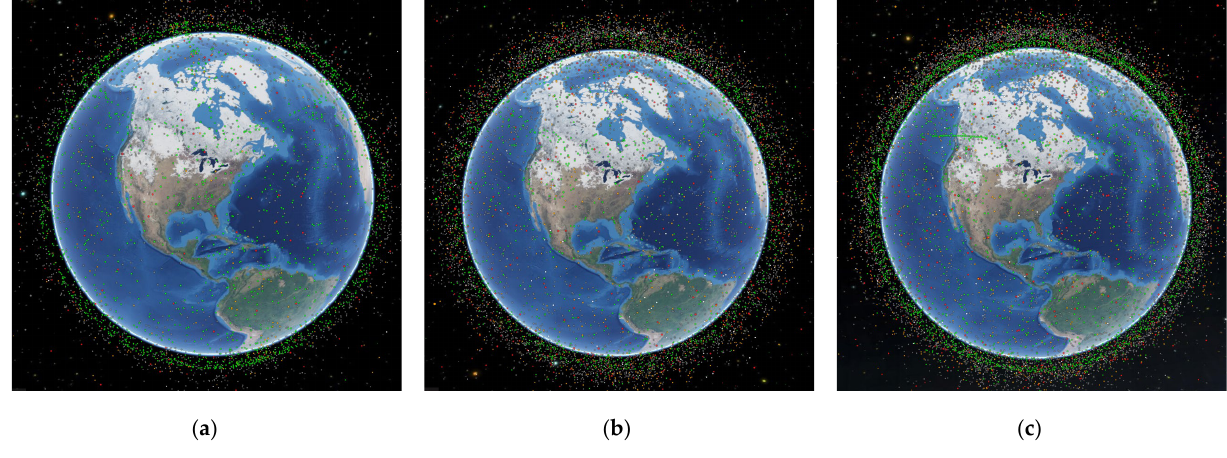
Figure 2. Changes in space catalogued objects in LEO, ( a ) 2000 ( b ) 2010, ( c ) 2022.[14].